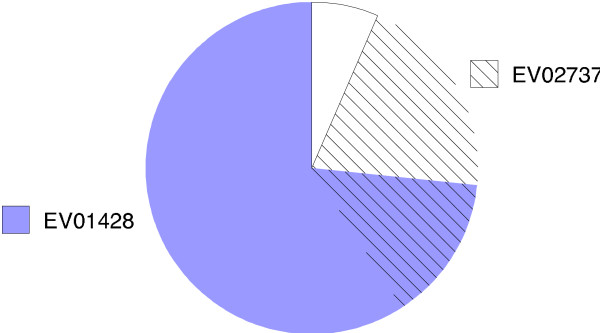
Coverage of [Pfam:PF00047] by [EVEREST:EV01.01428] and [EVEREST:EV01.02737]. Blue area – proportion of [Pfam:PF00047] domains covered by [EVEREST:EV01.01428]. Striped area -proportion of [Pfam:PF00047] domains covered by [EVEREST:EV01.02737]. Together, both EVEREST families cover 94% of [Pfam:PF00047]. For details of this example see Sub-families in section Examples: Selected EVEREST Families.